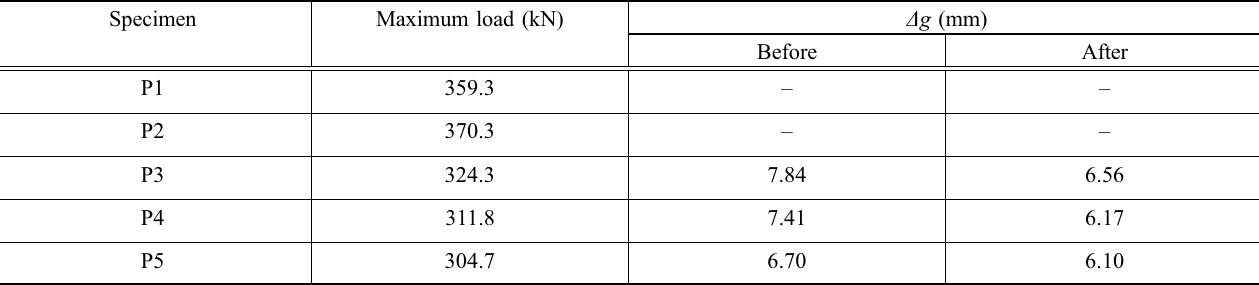
Fig. 12 Results of push-in tests. Table 1 Maximum loads and changes in gap between two wedge